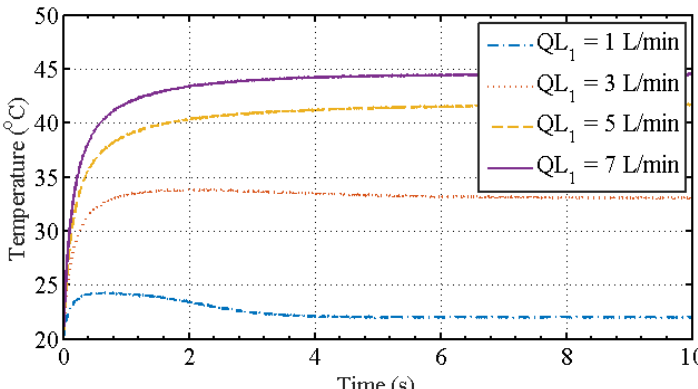
Figure 18. The output temperature in cold fluid with QL 2 = 5 L/min.